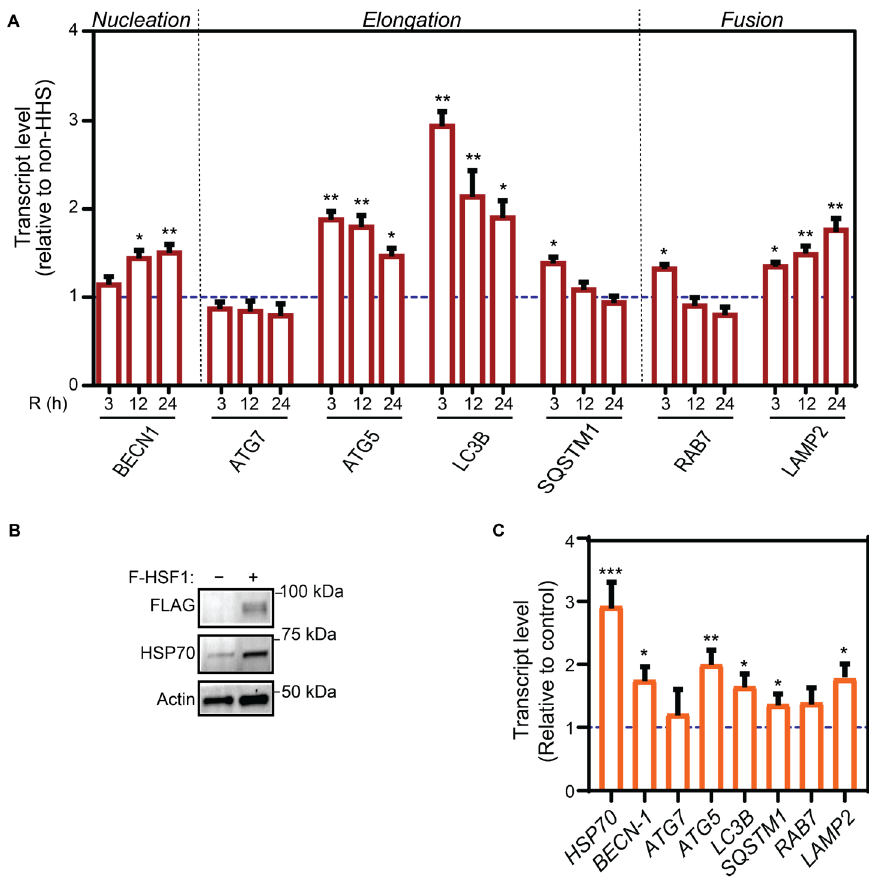
Figure 2. Hormetic heat response regulates the induction of autophagy-associated genes. ( A ) ARPE- 19 cells were treated without HHS (–) or with 30 min HHS (+) at 42 °C, followed by recovery at 37 °C. The expression level of transcripts involved in various stages of autophagy was analyzed by qPCR. ( B , C ) ARPE-19 cells were transfected with the FLAG-HSF1 expression construct at 37 °C. ( B ) Immunoblot analysis of FLAG, HSP70, and Actin for cells overexpressing HSF1 were illustrated with representative images. ( C ) Transcript levels of genes involved in various steps of the autophagy process in ARPE-19 cells under HSF1 gain-of-function were evaluated with qPCR. The dashed line (---) stands for non-HHS ( A ) or mock-transfected controls ( C ). R represents the post-HHS time of recovery at 37 °C. Data are reported as mean ± SEM ( n = 6) and statistical analysis was achieved using one-way ANOVA, followed by Sidak test (* p < 0.05, ** p < 0.01, *** p < 0.001).